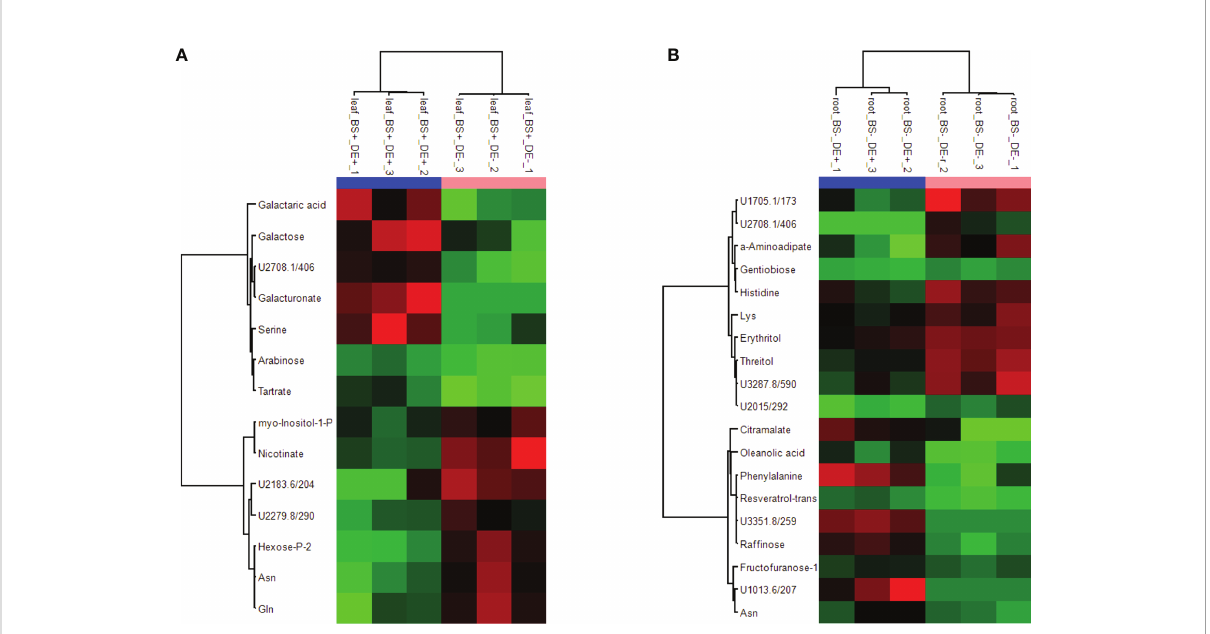
FIGURE 6 Heatmap showing metabolites differently accumulated in leaves and roots of plantlets treated by BS and/or DE. Grapevine micro-cuttings were transplanted in a solid medium supplemented with BS 0.1% (v/v, “ BS+ ” ) or water ( “ BS- ” , as control). At 4 wpt, they were divided into two sets: one treated by immersion in a defense elicitor solution (DE+) and the other one in water as control (DE-). Two days later, leaves, stems and roots were collected. Extracts were then prepared and analyzed by GC-MS. Signi fi cant differences were observed for BS+ modality in leaves (A) , and BS- modality in roots (B) . Data were processed using ANOVA (P <